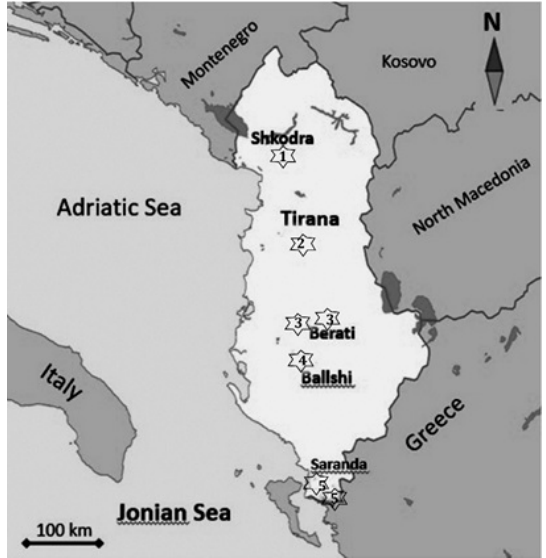
Figure 1. Location and distribution of the field survey regions of Hermann’s tortoises in five regions of Albania.